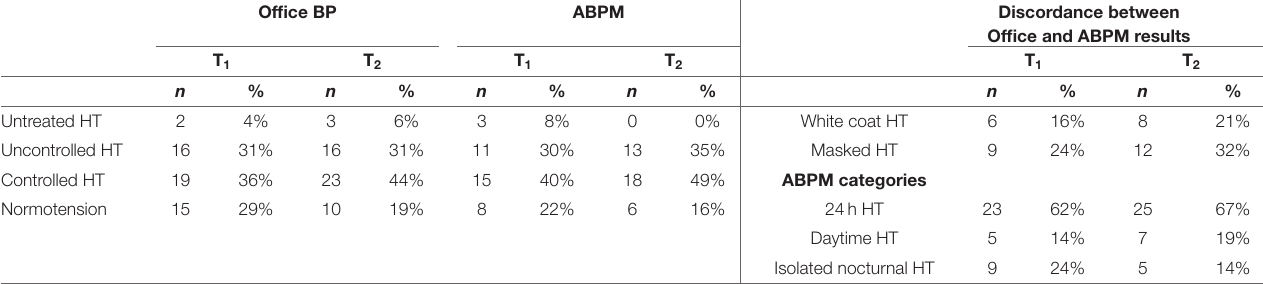
TABLE 3 | Blood pressure follow-up based on office blood pressures in the whole cohort ( n = 52), and ABPM measurements ( n = 37).